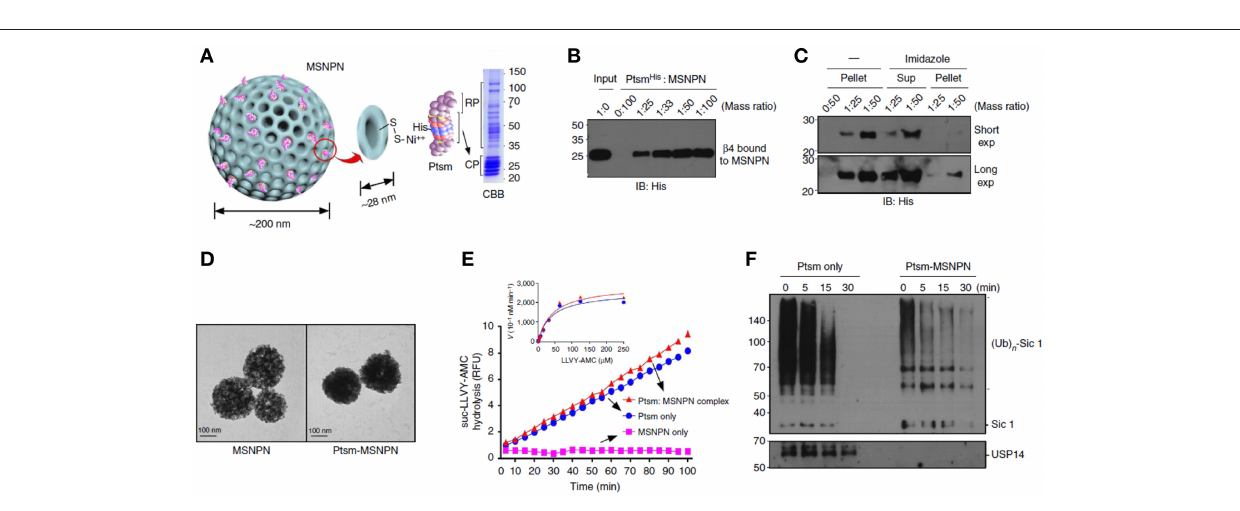
FIGURE 4 | MSNs delivered proteasome to degrade tau aggregates, a pathological hallmark of Alzheimer’s disease. Panel (A) was the schematic illustration and (B,C) showed the SDS-polyacrylamide gel electrophoresis (PAGE) staining of MSNs- proteasome interaction. Panel (D) showed the TEM images of MSNs and proteasome loaded MSNs. Hydrolysis assay (E) and western blots studies (F) demonstrated the degradation of tau aggregates, indicating the delivery of active form of proteasomes by MSNs. Reproduced with permission from Han et al. (2014), The Nature Publishing